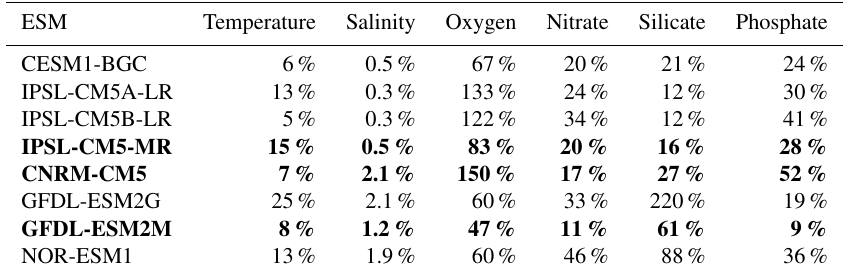
| X model (z) − X obs (z) | and then X obs (z) 27% 52%